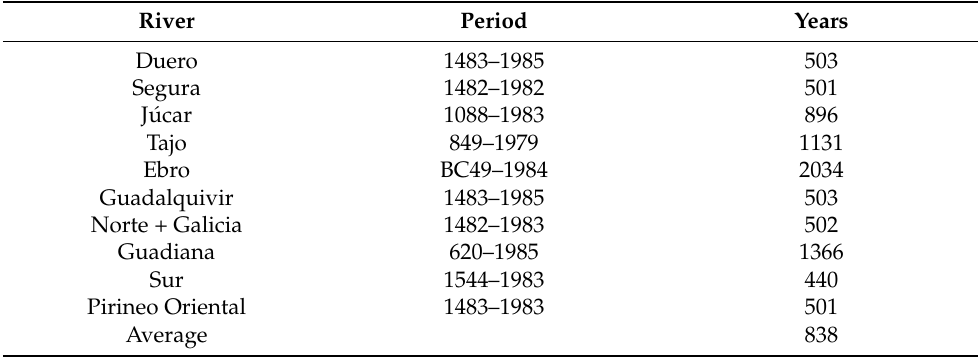
Table 2. Detail of the years covered by flood databases of all Spanish Basins contained in CNIH Barriendos et al.,